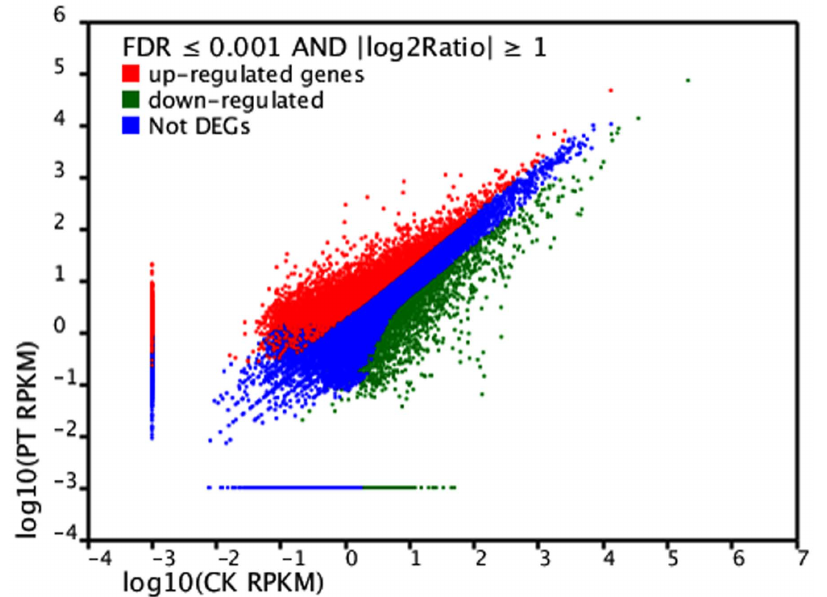
Figure 3. Comparison of gene expression level between the two libraries. For comparing gene expression level between the two libraries, each library was normalized to 1 million tags. Red dots represent transcripts more prevalent in the phenol treatment library, green dots show those present at a lower frequency in the infected tissue and blue dots indicate transcripts that did not change significantly. The parameters ‘‘FDR , 0.001’’ and ‘‘log2 Ratio $ 1’’ were used as the threshold to judge the significance of gene expression difference.